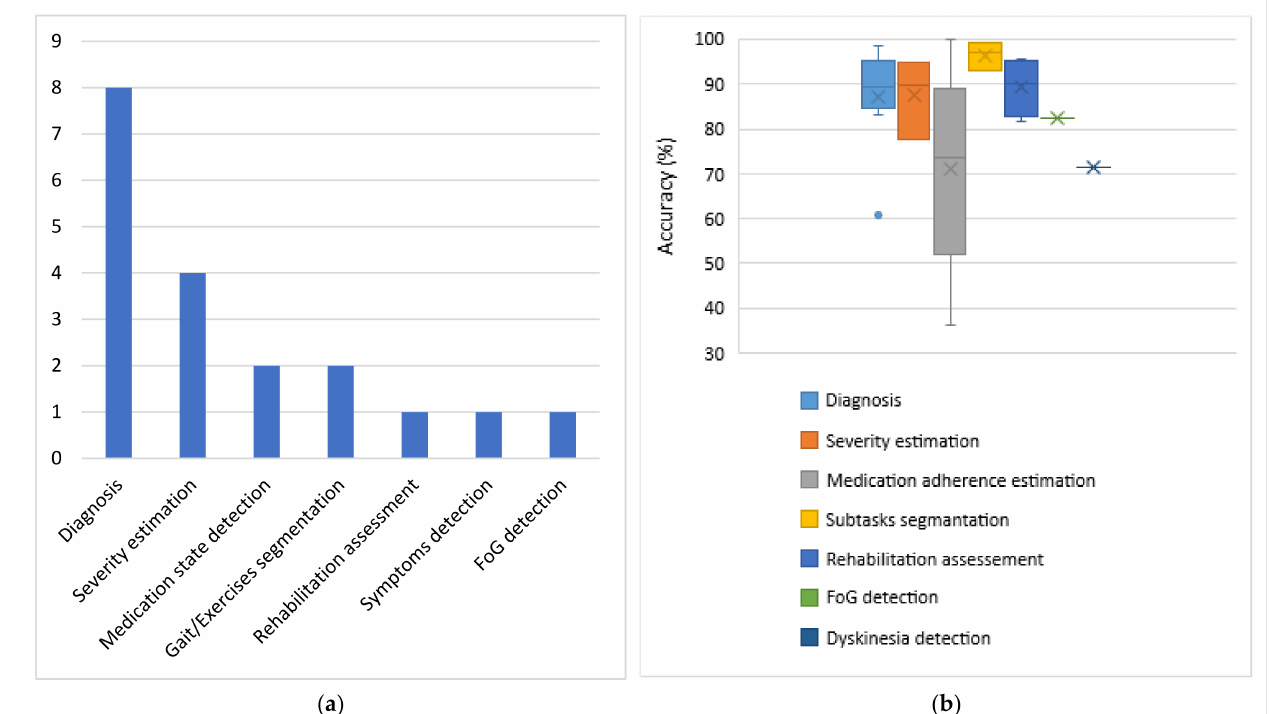
Figure 7. PD problems addressed based on image and depth sensors and the respective obtained accuracies. ( a ) Number of studies per task; ( b ) accuracies obtained from the proposed models for each category of addressed tasks. Number of studies considered in this boxplot per task: n = 7 for diagnosis, n = 3 for severity estimation, n = 2 for medication adherence estimation, n = 2 for subtasks segmentation, n = 1 for rehabilitation assessment, n = 1 for FoG detection and n = 1 for dyskinesia